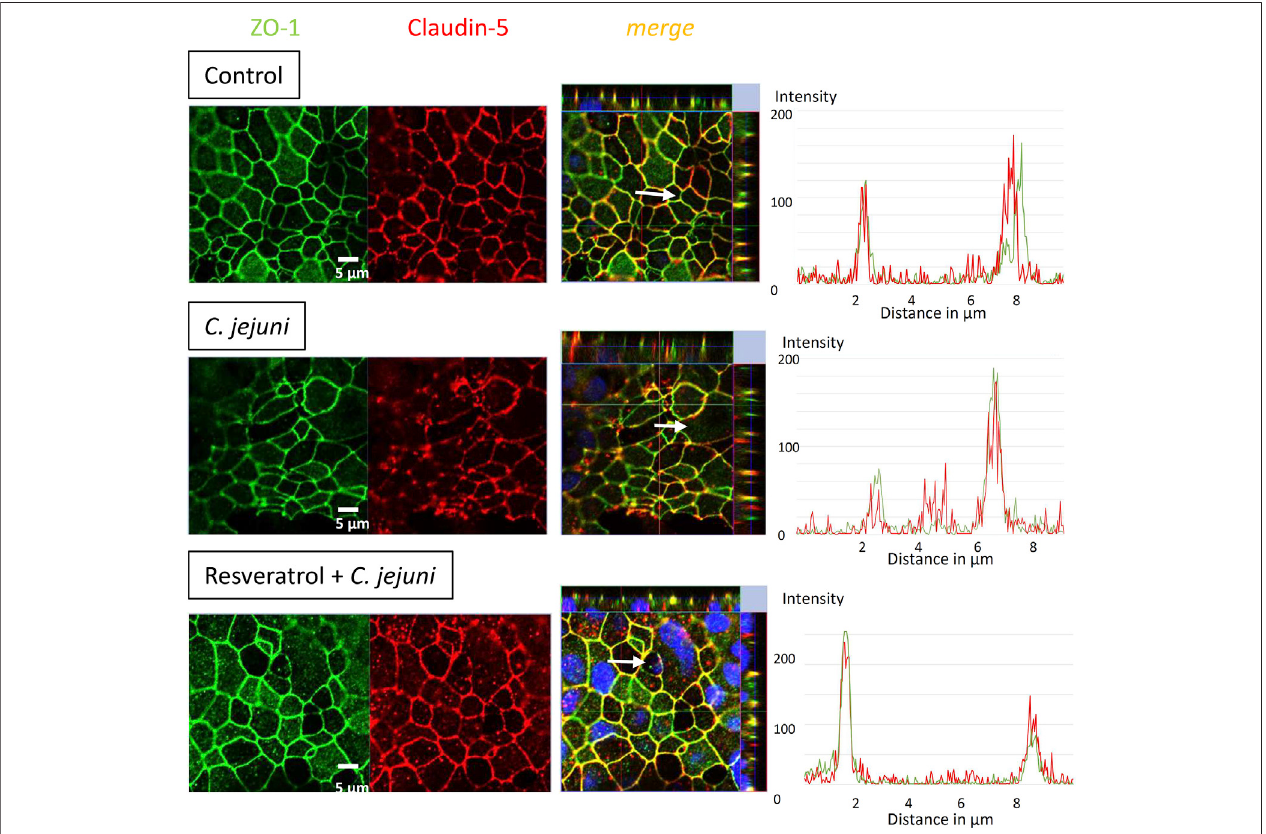
FIGURE4| Subcellulartightjunctionproteindistributionofclaudin-5under Campylobacterjejuni infectionandresveratroltreatment.Resveratrolmitigates C.jejuni - induced re-distribution of claudin-5. HT-29/B6-GR/MR cells were treated with resveratrol and infected with C. jejuni from apical. 48 h post-infection monolayers were stainedwithantibodiesagainstclaudin-5(red)andZO-1(green).NucleiwerestainedbluewithDAPI(bar5 µm).IntensityplotspointtosignalsoftheTJproteinsalongthe white arrows in the merge pictures. The intensity signals appear highest in the TJ domain with a proper co-localization under control conditions and vary under infection and treatment conditions with the white arrows depicted over single